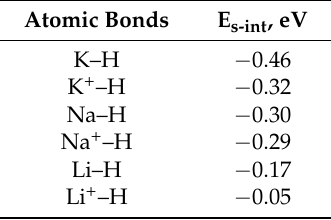
Figure 5. Energy curves of the scanning process of an arbitrary surface containing with atoms and ions: 1 Li atom; 2 K atom; 3 Na atom; 4 Li + ion; 5 Na + ion; 6 K + ion, surface-modified system “CNT + NH 2 ” The 1 Å point is located under the hydrogen atom of the amino group, to which the metal atom moves. Table 2. Sensor interaction energy E s-int between amino group surface modified nanotube system and Li, Na, K atoms and